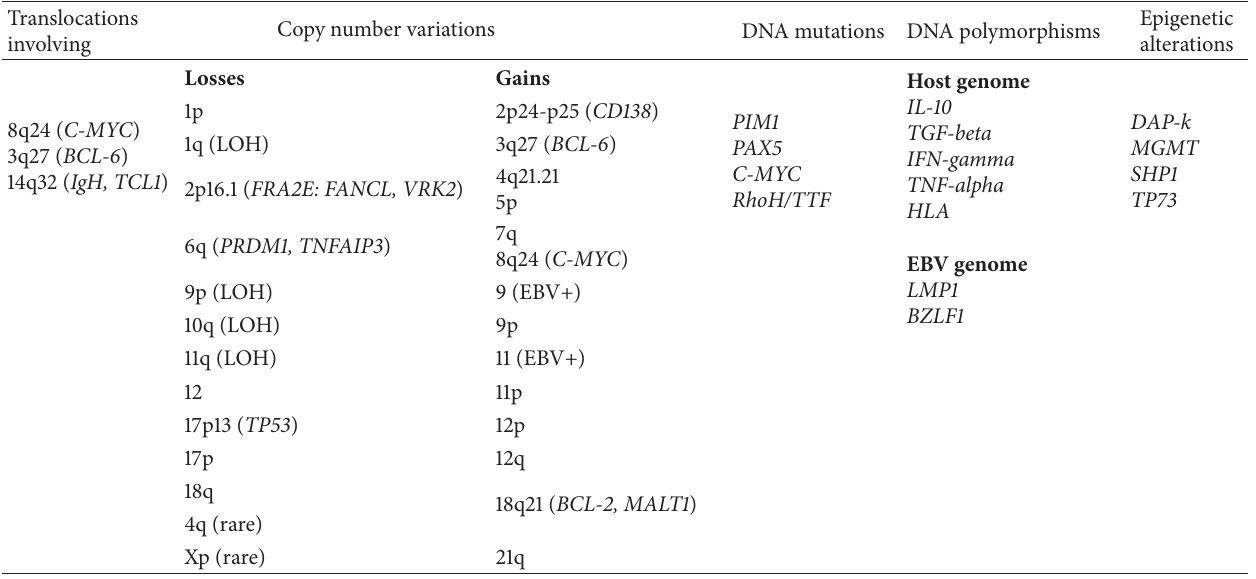
Table 1: Most common genetic and epigenetic alterations detected in B-cell posttransplant lymphoma.